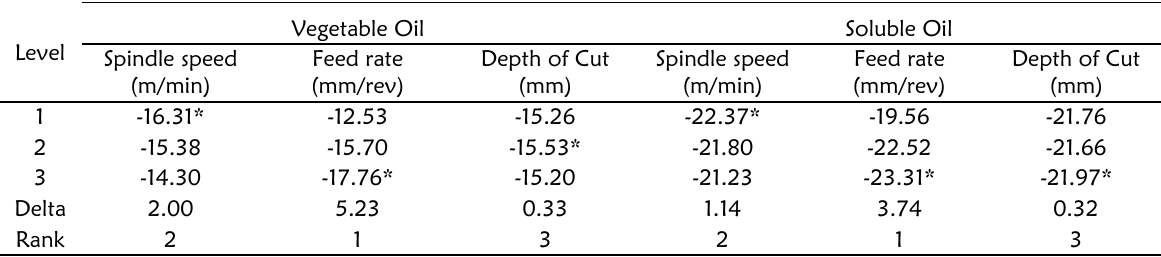
Table 5: Response Table for Signal to Noise